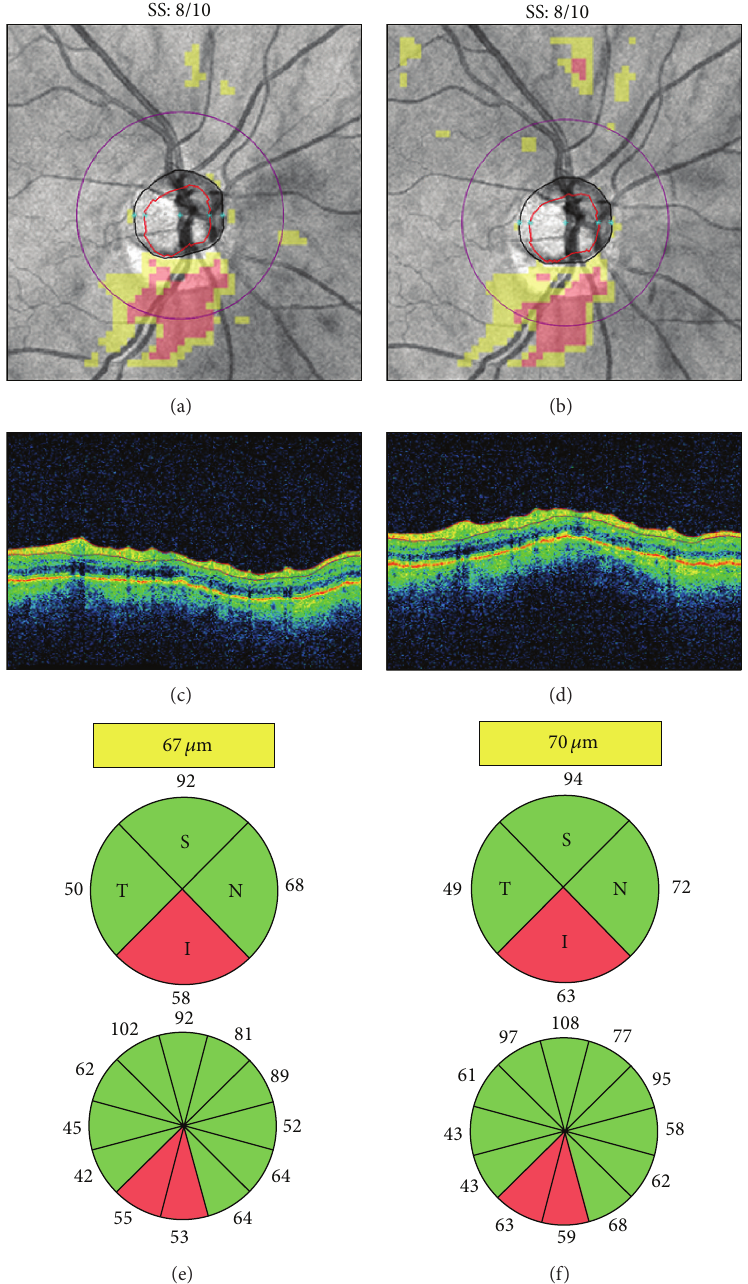
Figure 1: Dry eye. Cirrus HD-OCT retinal nerve fiber layer (RNFL) deviation maps ((a)-(b)), circular tomograms ((c)-(d)), and printout results ((e)-(f)) before (left) and after (right) instillation of artificial tears. Note the OCT color enhancement on the circular tomogram (d) and the overall increased RNFL thickness after adequate ocular lubrication (f). SS: signal strength.